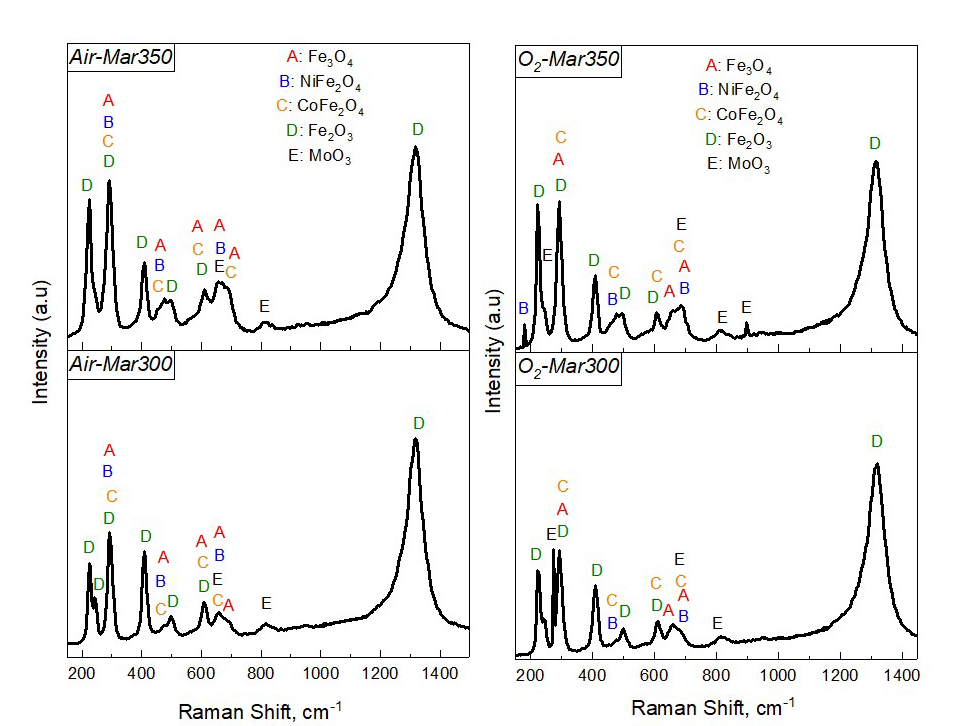
Figure 12. Raman spectra of the oxide layer growth under different atmospheres on maraging 300 and 350 alloy.